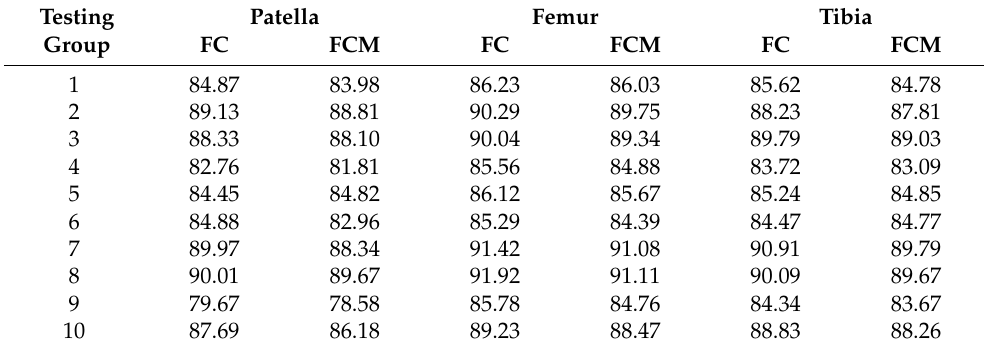
Table 9. Dice index values for the 10 tested MRI series (NYU fastMRI Initiative database) for the FC and FCM